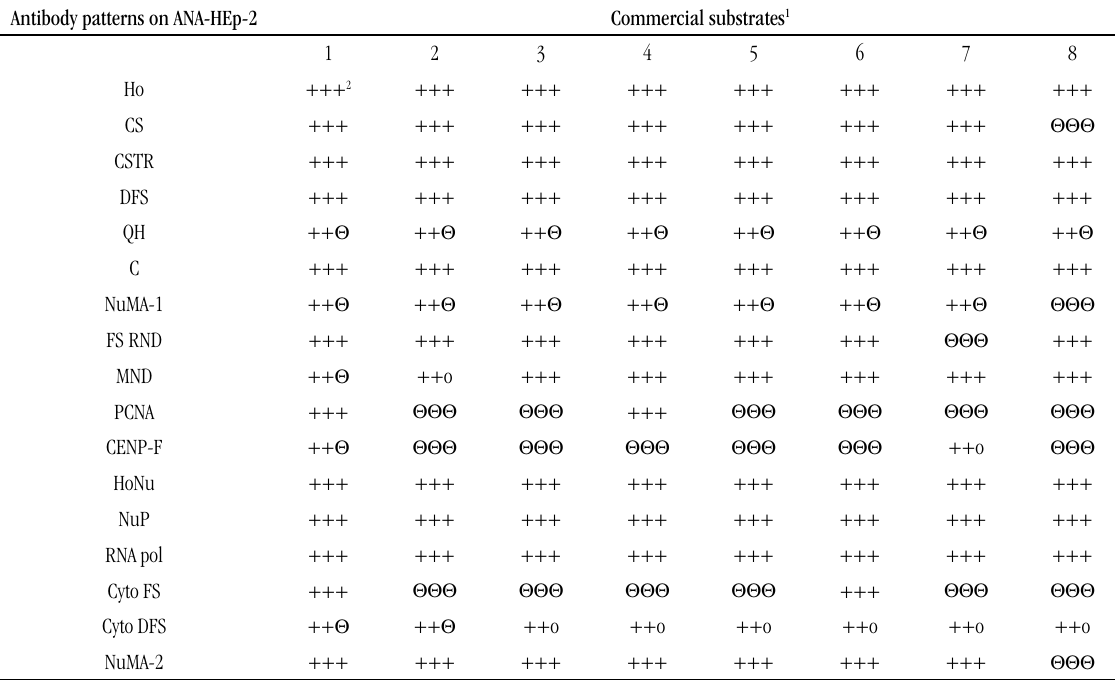
tABLE 2 – Interpretation results of IIF patterns on ANA-HEp-2 from each participating center Antibody patterns on